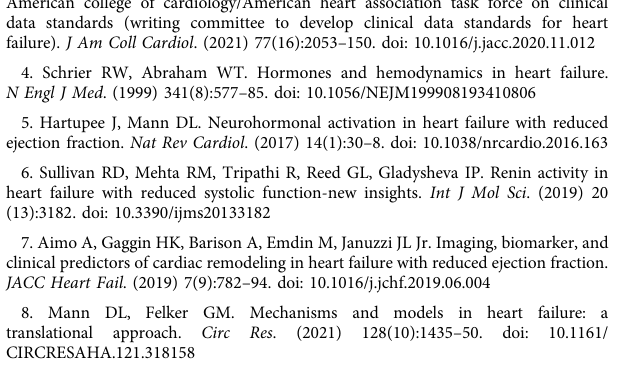
Figure generation. GLR: contributed to the conceptualization, editing and illustration of the manuscript. All authors contributed to the article and approved the submitted